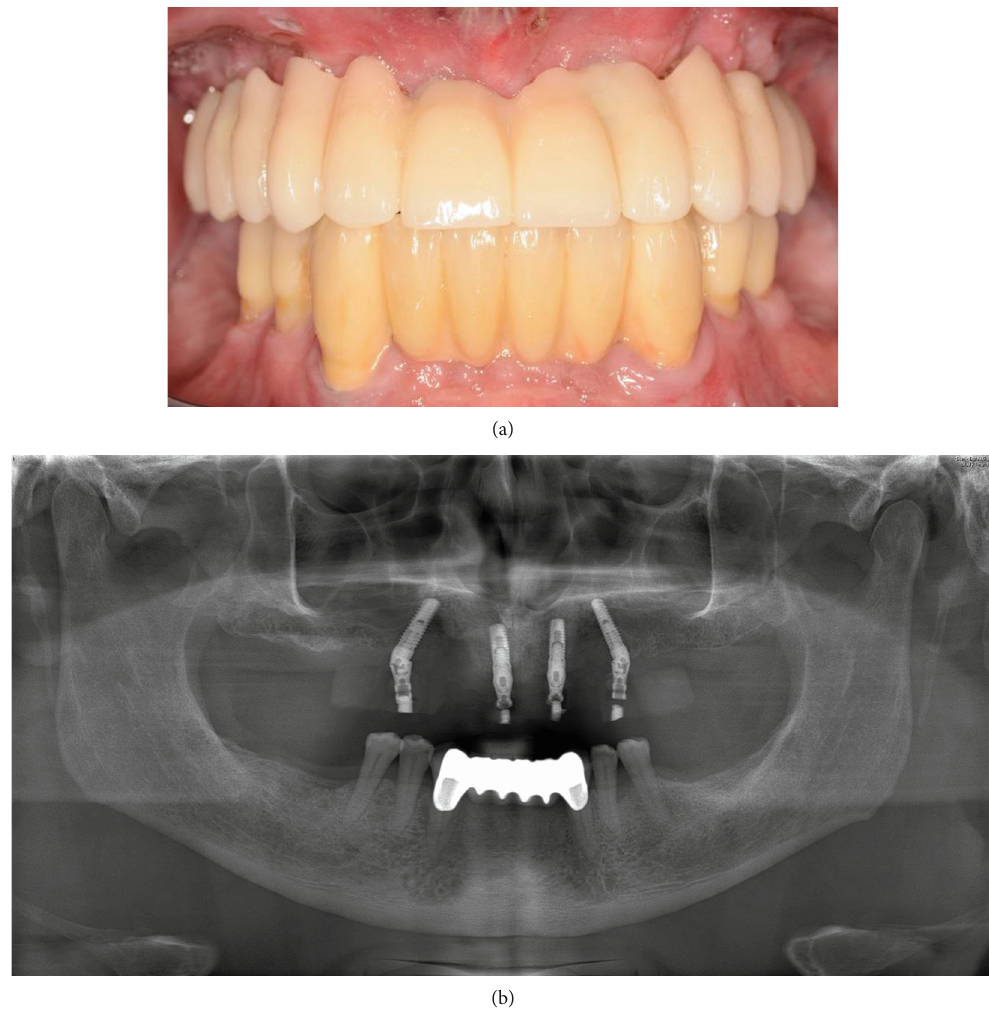
Figure 8: (a) Frontal view of the fi nal inserted provisional FPD. (b) Orthopantomogram to control the implant